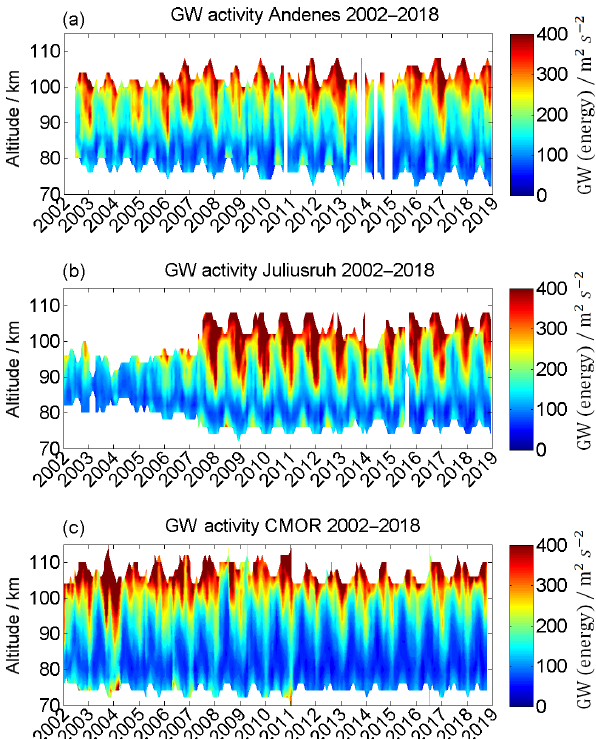
Figure 15. Time series of planetary wave energy for Andenes (a) , Juliusruh (b) , and CMOR (c) . The red (green) bold arrows corre- spond to winter with a major (minor) sudden stratospheric warm- ing.